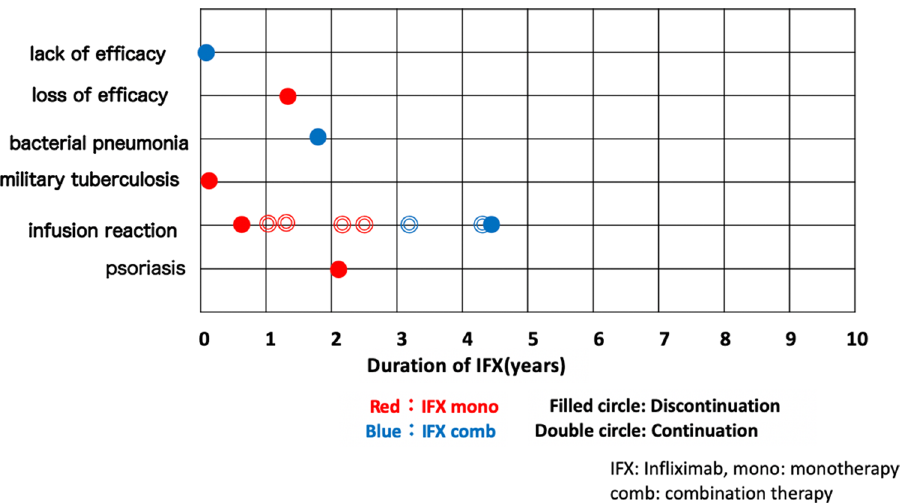
Figure 5. Occurrence and timing of adverse events. Filled circle shows the timing of the adverse events and the subsequent discontinuation of IFX. Double circle indicates the timing of AEs during the continuation of IFX. All of the AEs were seen during initial 5-year period, with no discontinuations or AEs noted after 6 years of continuous